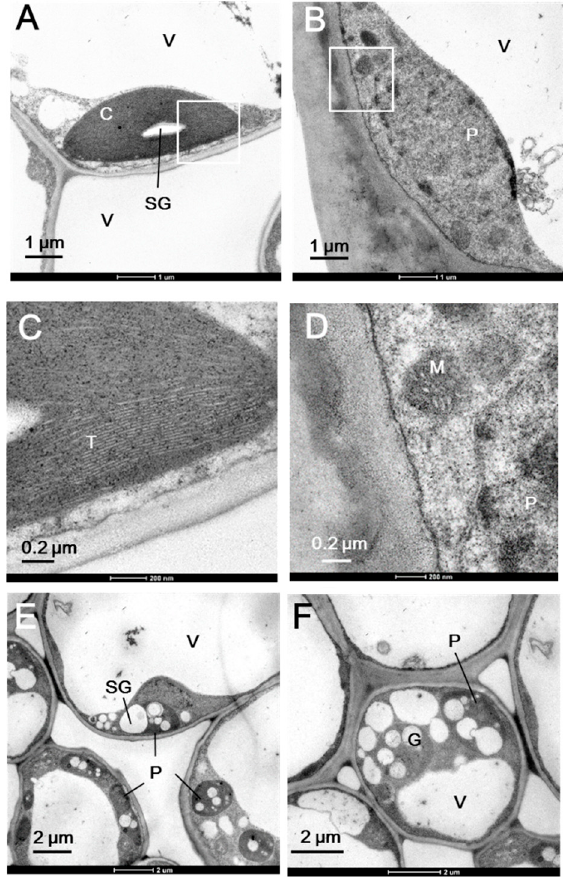
Figure 2. Chloroplast ultrastructure of the green ( A , C ) and white ( B , D – F ) sectors in milky stripe fig leaves. White inserts in ( A ) and ( B ) are shown in ( C ) and ( D ), respectively. C, chloroplast; M, mitochondria; P, plastid; SG, starch granule; T, thylakoid; V, vacuole.